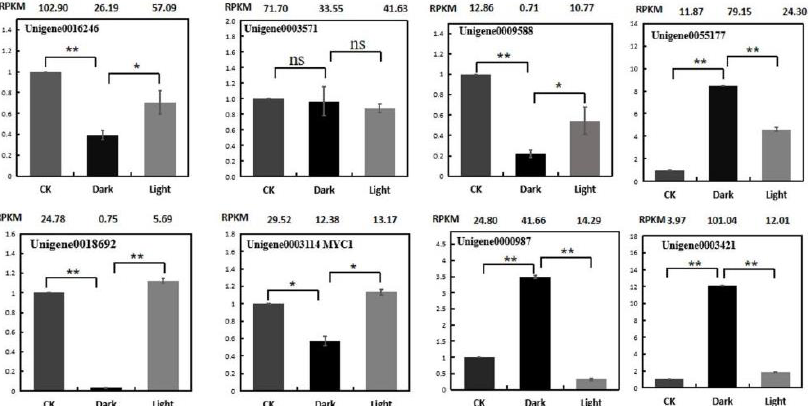
Figure 10. Expression validations of eight selected genes in the control, darkness and recovery light samples using qRT-PCR. The RPKM values obtained from the RNA-Seq data are depicted at the top of each figure. The level of significance, determined via Student’s t -test, is depicted as follows: * p < 0.05; ** p < 0.01. ns, not significant. Each value is the mean of at least three replicates.